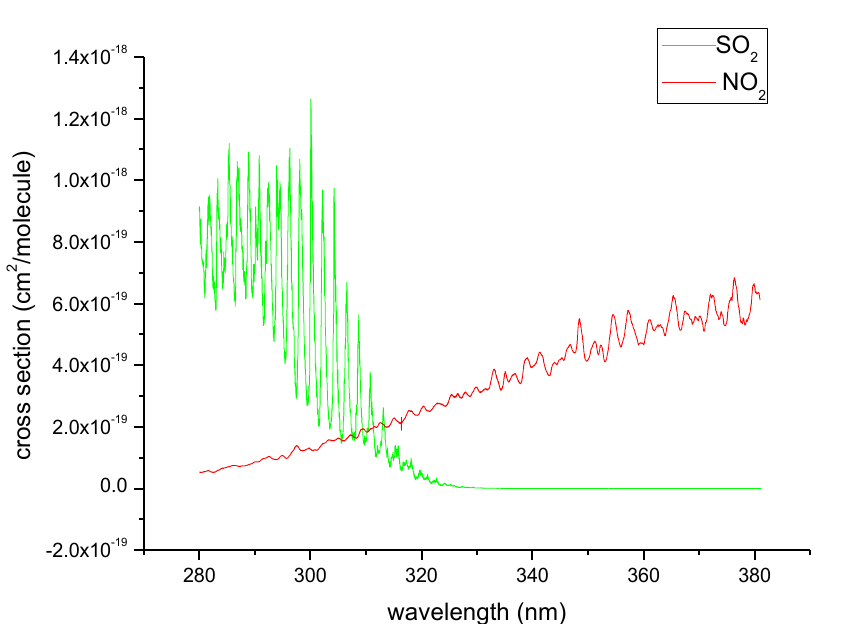
Figure 1. SO 2 and NO 2 absorption cross-sections (data source: the HITRAN 2016 molecular spectro- scopic database [26]).